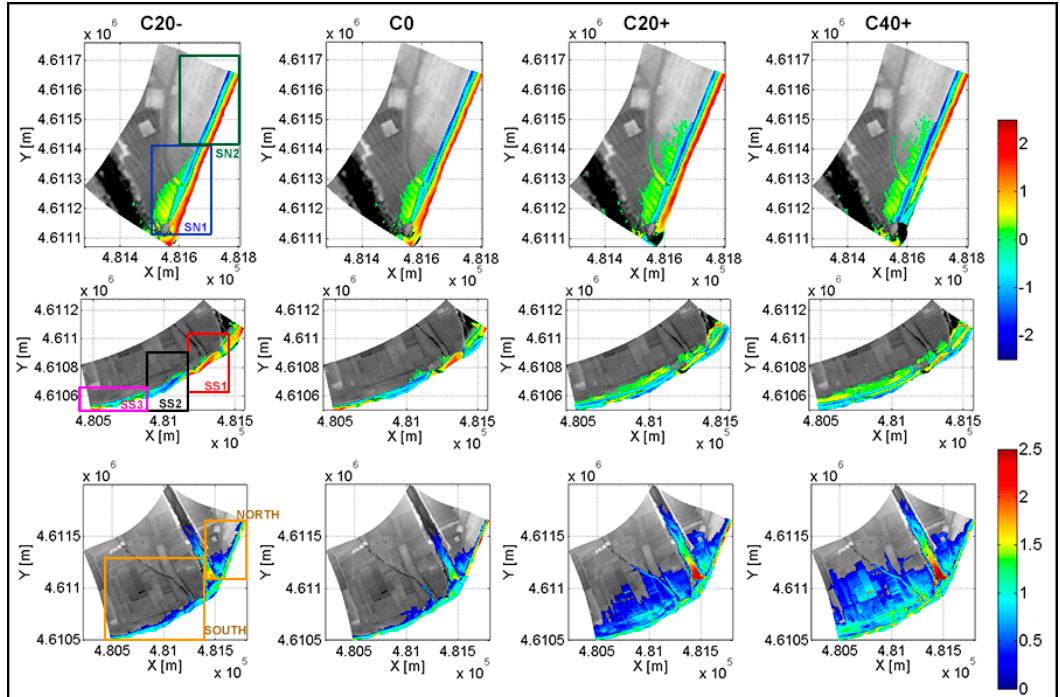
Figure 8. XBeach-simulated inundation depth (m) ( bottom ) and bed level changes (m) northwards Figure 8. XBeach ‐ simulated inundation depth (m) ( bottom ) and bed level changes (m) northwards ( top ) and southwards ( middle ) of the Tordera ( top ) and southwards ( middle ) of the Tordera River.